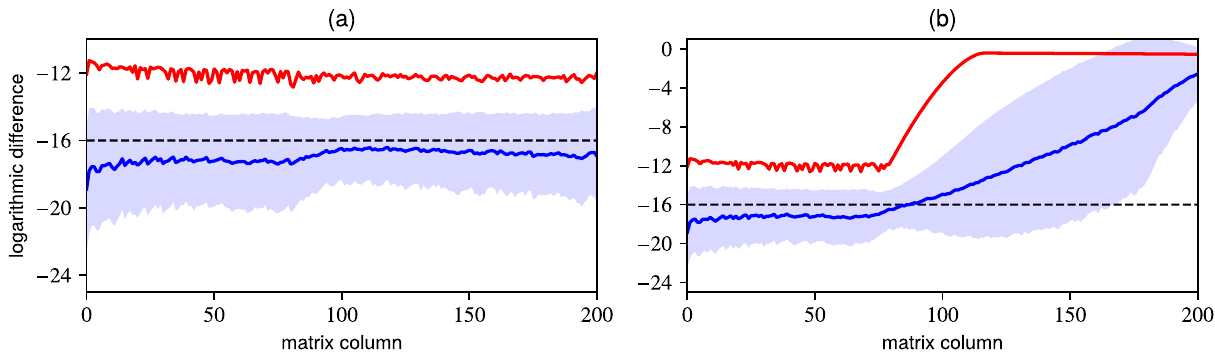
201 and = i ( L ij ) values, light-